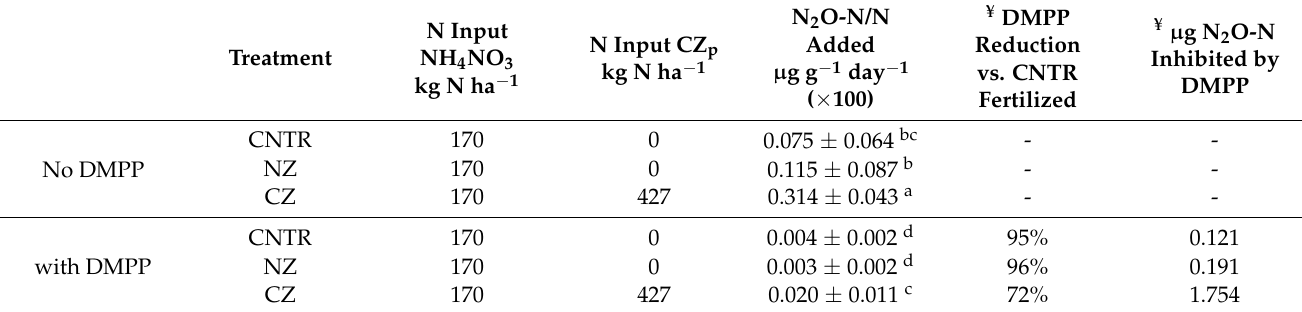
Table 5. Amount of N 2 O-N emitted per unit of N added in each treatment, the entity of reduction operated by DMPP addition compared to the fertilized control, and amount of N 2 O-N inhibited in each treatment. The N 2 O-N emissions rate used for calculations are shown in Table 4. Different letters express significant differences as a result of ANOVA and Tukey-HSD statistical tests ( p < 0.05). ¥ Mean values were used for